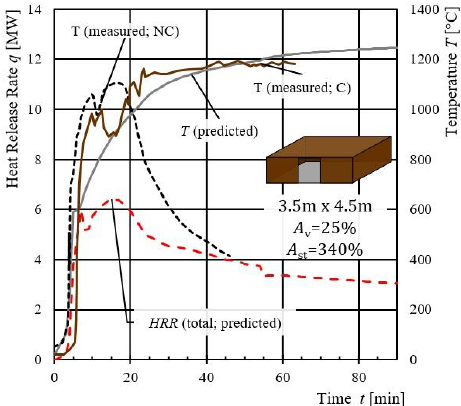
Figure 24: Predicted and measured temperatures for the predicted